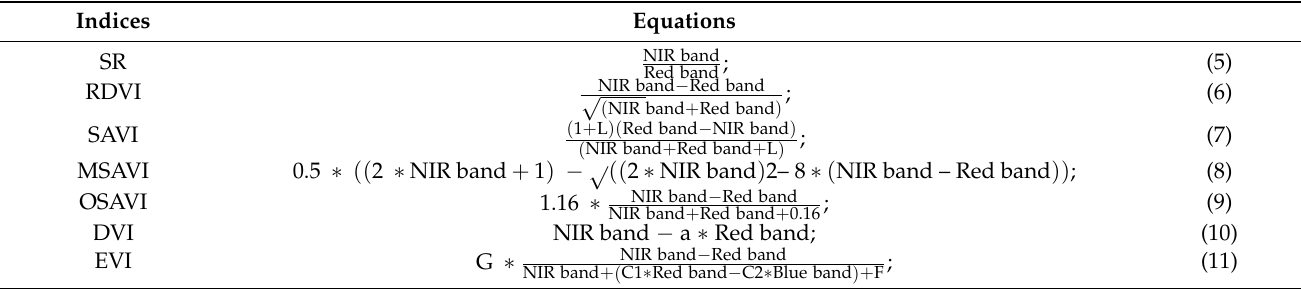
Table 5. Equations of different spectral indices